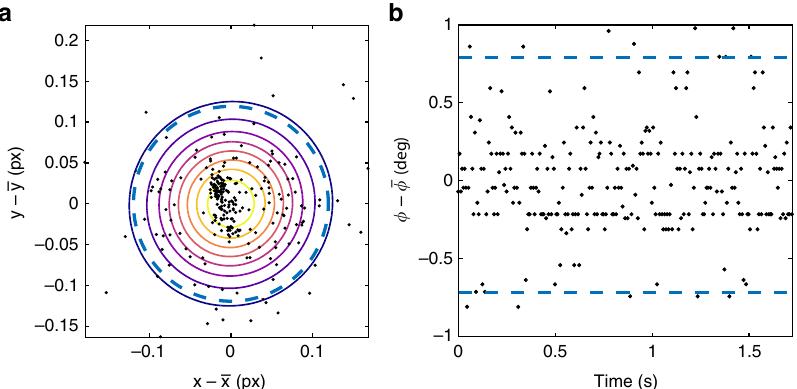
Fig. 8 Accuracy of spatial and angular detection. a Tracked positions of a sticking particle during a time interval of 1.2 s. Solid lines show the isocontours of a bivariate mixed Gaussian distribution. The dashed line shows a circle with a radius equal to two times the square root of the maximum diagonal entry of the covariance matrix. b Orientations of a sticking particle. Dashed lines mark the con fi dence interval that includes at least 95.4% of the data